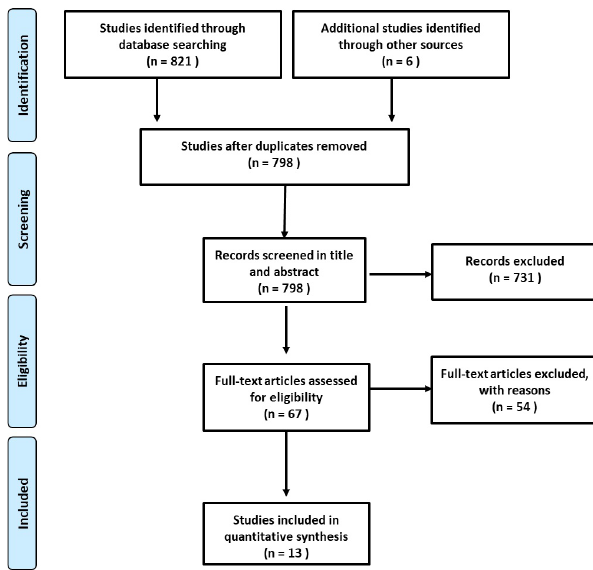
Figure 1: The studies electronic searching flow